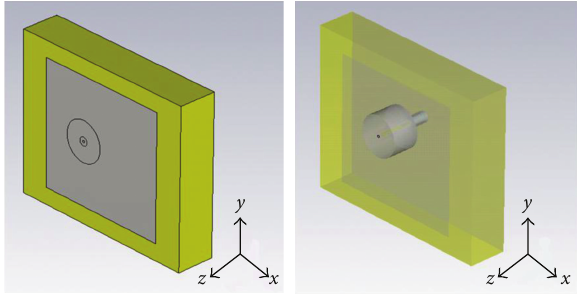
Figure 2: Patch antenna